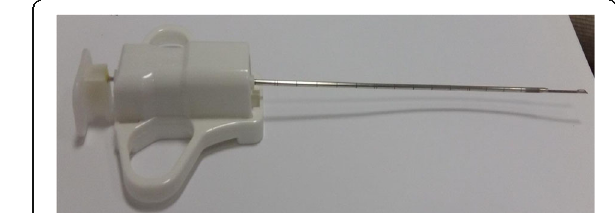
Fig. 2 Photographic plate of the probes. (1) Convex probe 2 – 5 MHz. (2) Mini-convex probe 4 – 8 MHz. (3) Linear probe 9 – 13